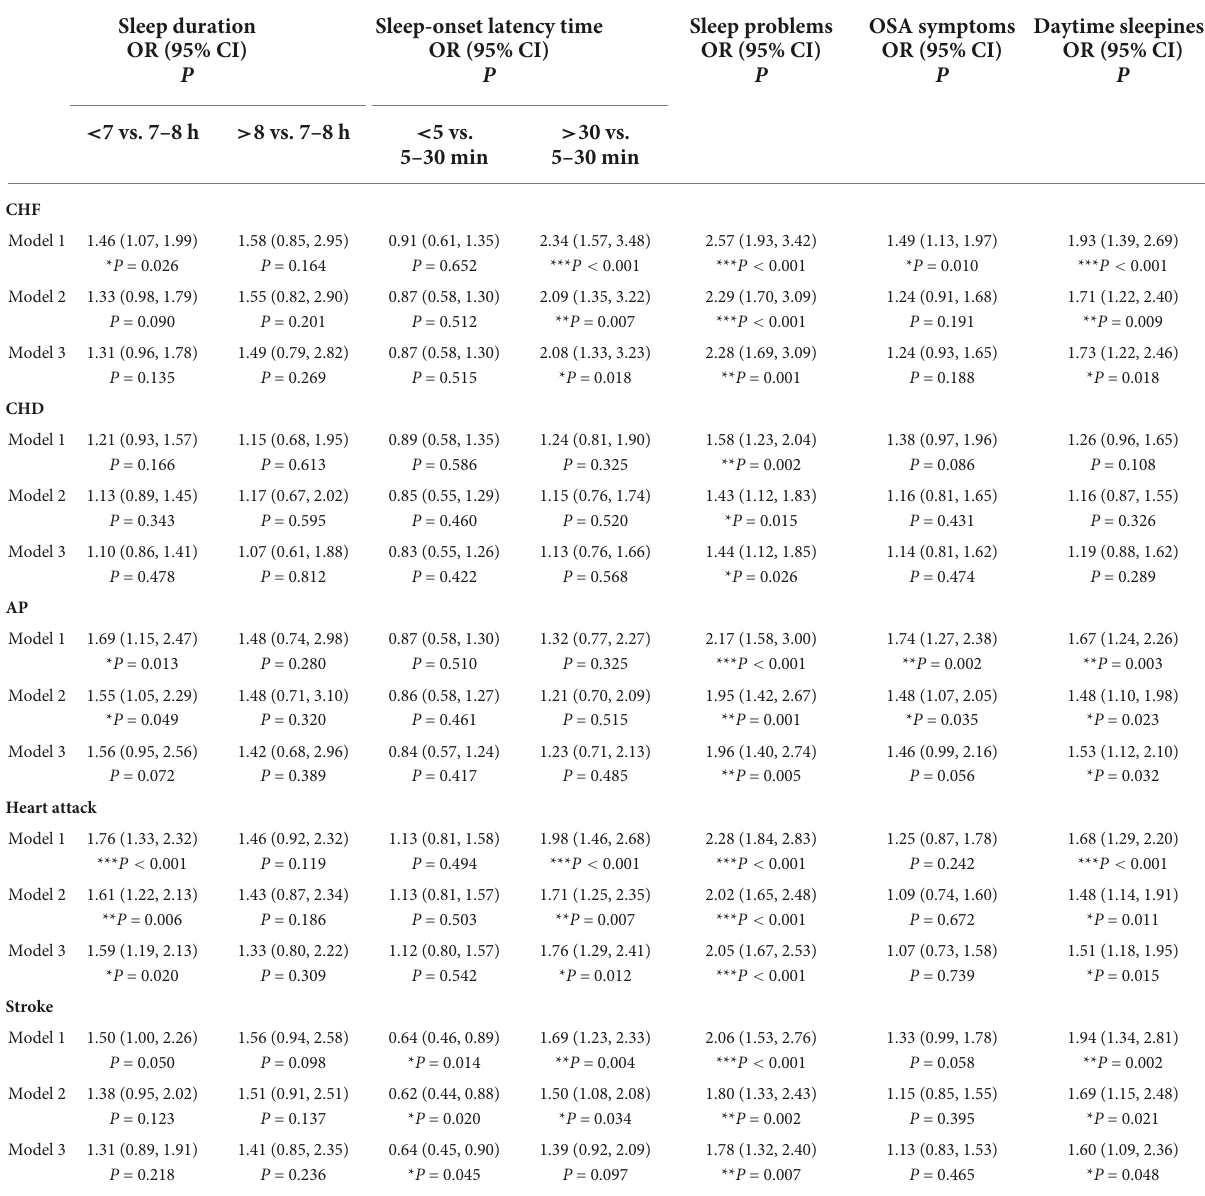
TABLE 3 Adjusted odds ratios for associations between sleep-related disorders and individual CVDs. Sleep duration OR (95%